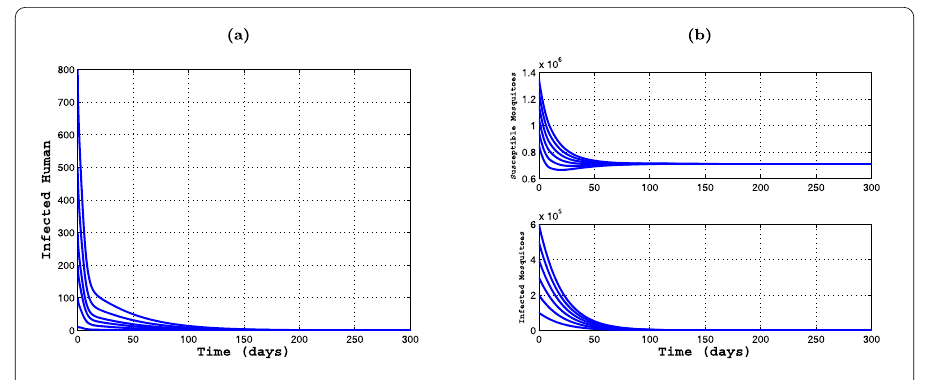
Figure 3 The global attractiveness of the disease-free equilibrium without mosquitoes E 01 of model (1), where R 01 ≈ 0.9330 < 1.